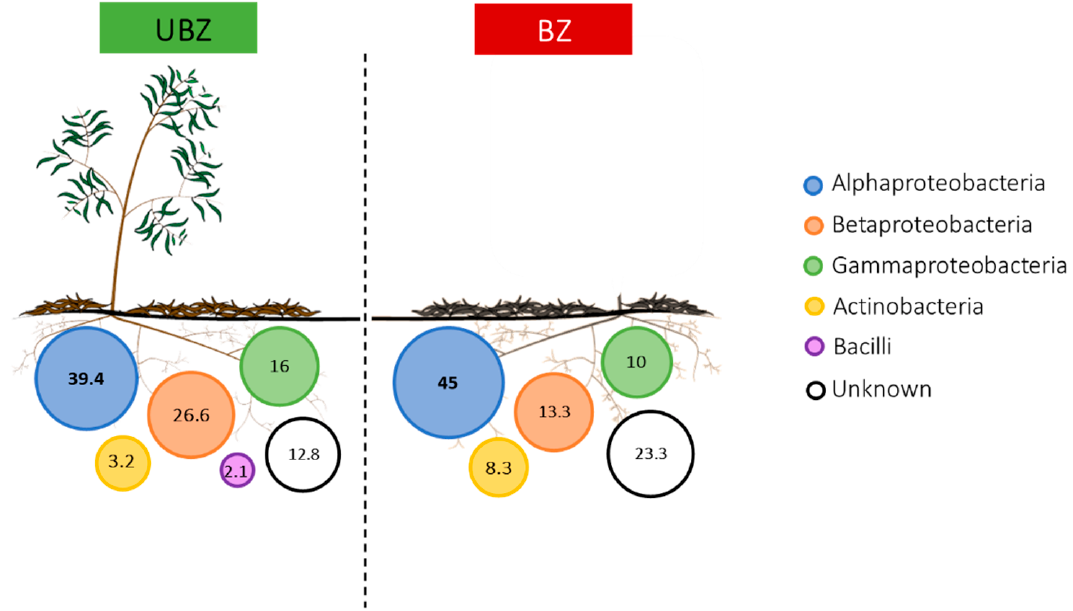
Figure 3. Percentage of the distribution of the different phyla/class of bacterial isolates from A. longifolia young plants nodules, present in both unburnt (UBZ) and burnt zones (BZ).